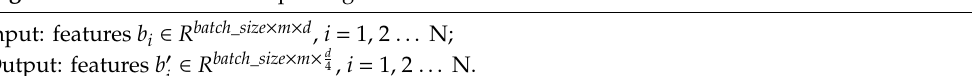
Algorithm 2 Multi-scale max pooling